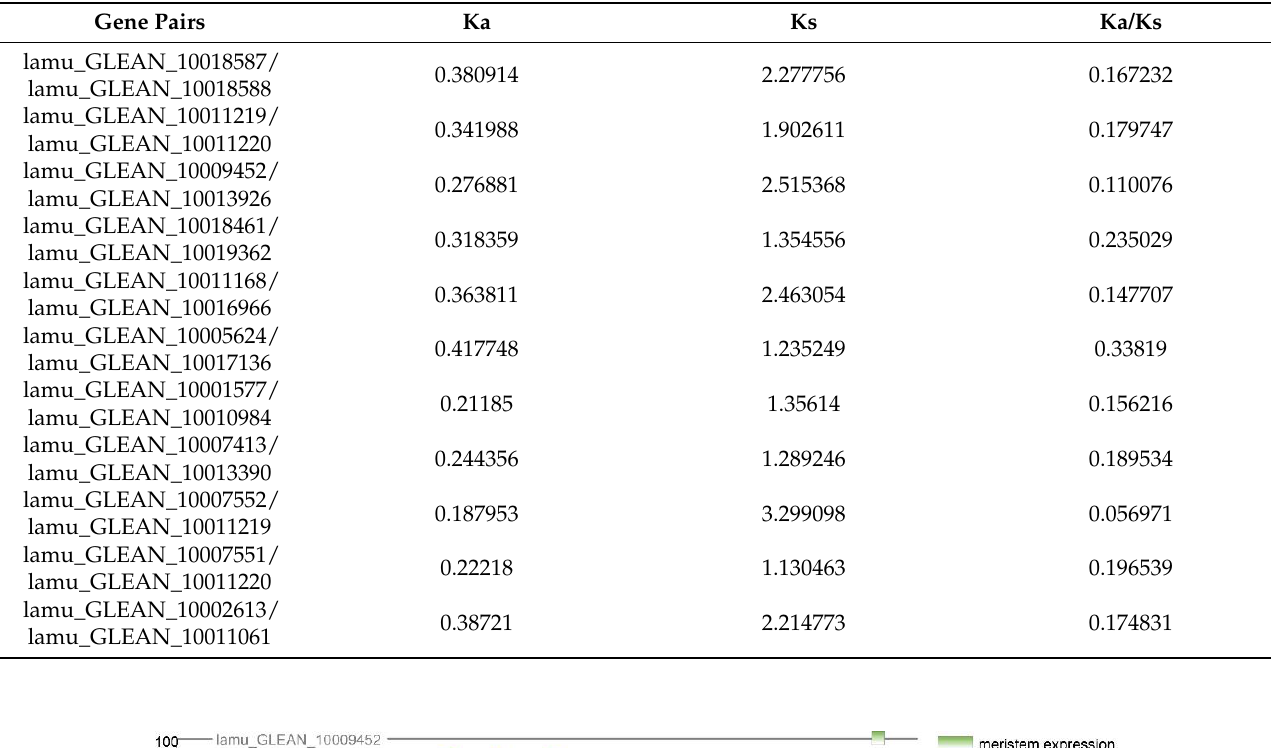
Table 2. Analysis of Ka/Ks for the MoIAAs.